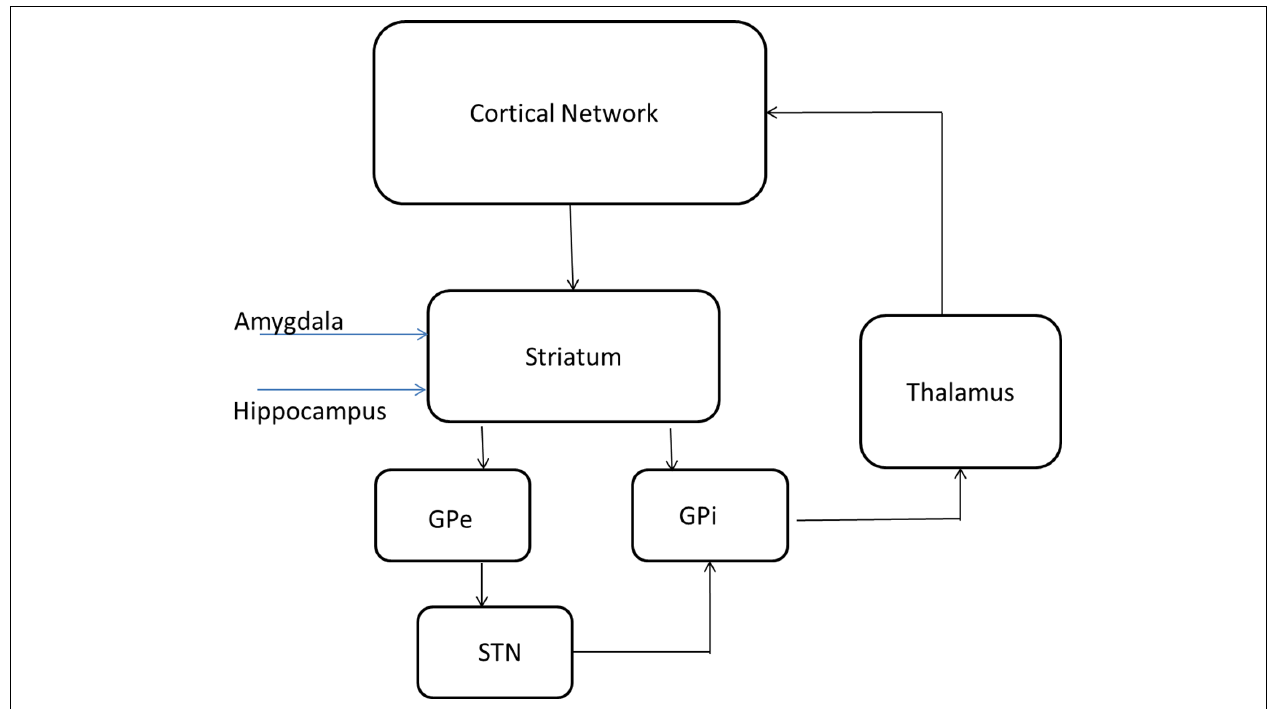
FIGURE 2 | Circuitry and receptor effects for the proposed cortical-basal ganglia-thalamic model. A working memory subcircuit (Durstewitz etal., 2000) maintains a burst of activity representing working memory span.Two types of medium spiny neurons in the striatum (Gruber etal., 2003), D1 and D2 project inhibitory ( − ) synapses to GPi (direct pathway) and GPe (indirect pathway) respectively.The GPe neurons are reciprocally coupled to themselves and the subthalamic nucleus (STN; Rubin andTerman, 2004; Pirini